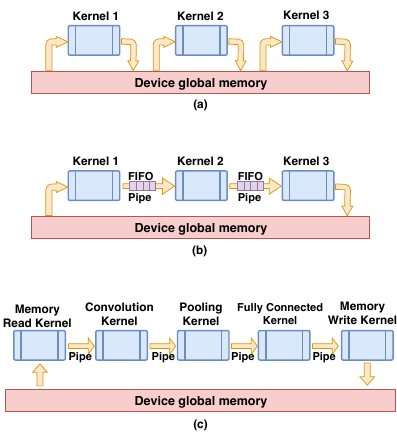
Figure 4. ( a ) Memory access pattern in OpenCL standard 1.x. ( b ) OpenCL pipes; in FPGAs, pipes are implemented as FIFOs. ( c ) Deeply pipelined CNN network